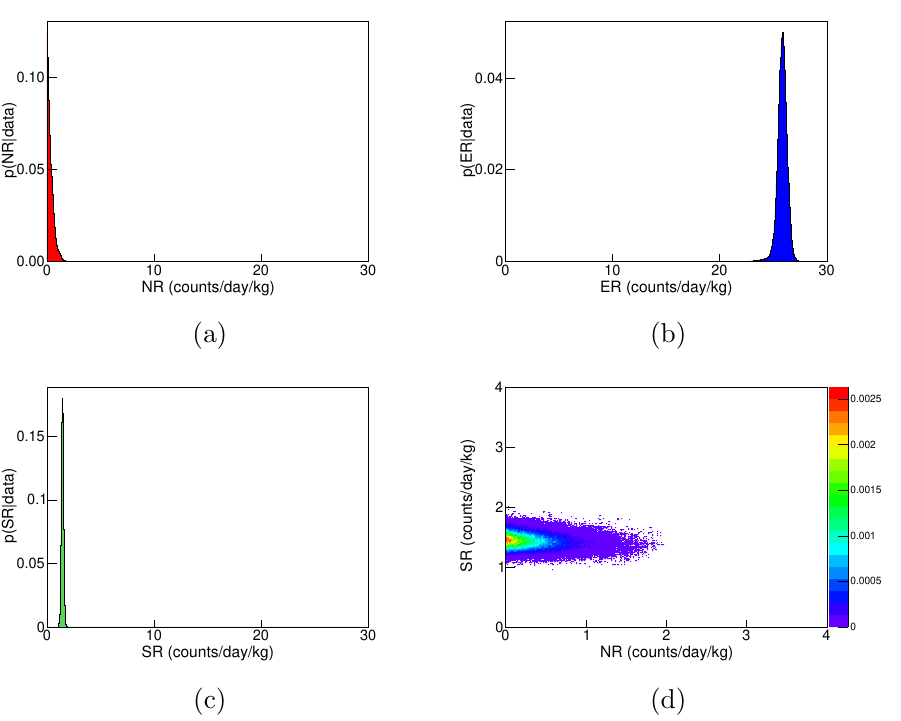
Figure 6 . The posterior PDFs for: (a) NR events; (b) ER events; and (c) SR events for 2 (cid:0) 8 keV of NaI2 normalized to time (day) and mass (kg). (d) Two-dimensional distribution of posterior NR and SR PDFs, where no correlation is